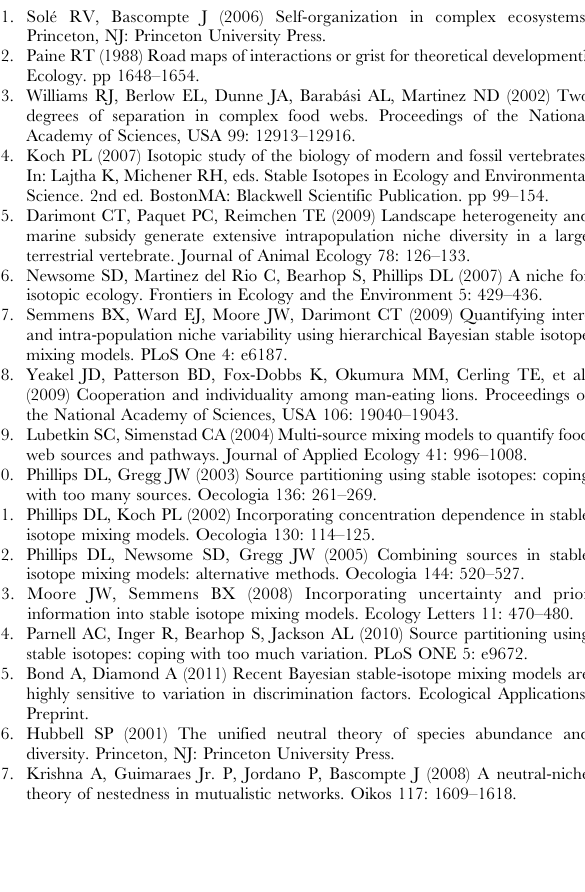
model result means; slope= 0.11, R 2 =0.53. The hatched red lines represent the 90% confidence interval. Figure S3 Manipulation of the isotopic overlap of prey. A ) A mixing space with 2 non-overlapping prey (green, red), two overlapping prey (blue, orange), and a single consumer (black). Here, the overlap of blue and orange prey ( w blue,orange )=1. B ) MixSIR estimates of % contribution to diet for each prey associated with Fig. S.3.A. Green and red are predicted to contribute equally to the consumer’s diet, as are blue and orange. C ) An alternative mixing space such w blue,orange = 0. Here, the blue and orange prey have been symmetrically moved from their previous isotopic values ( d 13 C= 2 8, d 15 N= 5) to Blue: d 13 C= 2